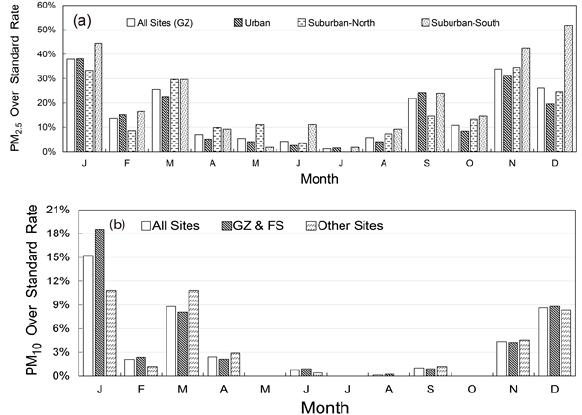
Fig. 6. Percentage of PM 2.5 or PM 10 non-attainment days per month in 2010 a) PM 2.5 in Guangzhou and b) PM 10 in PRD.